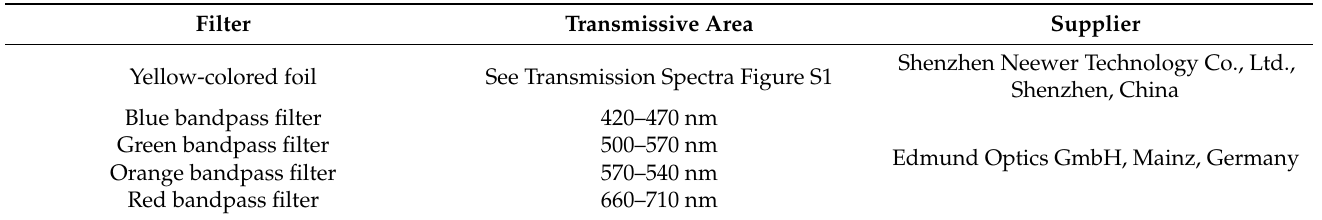
Table 3. Overview of tested emission filters.